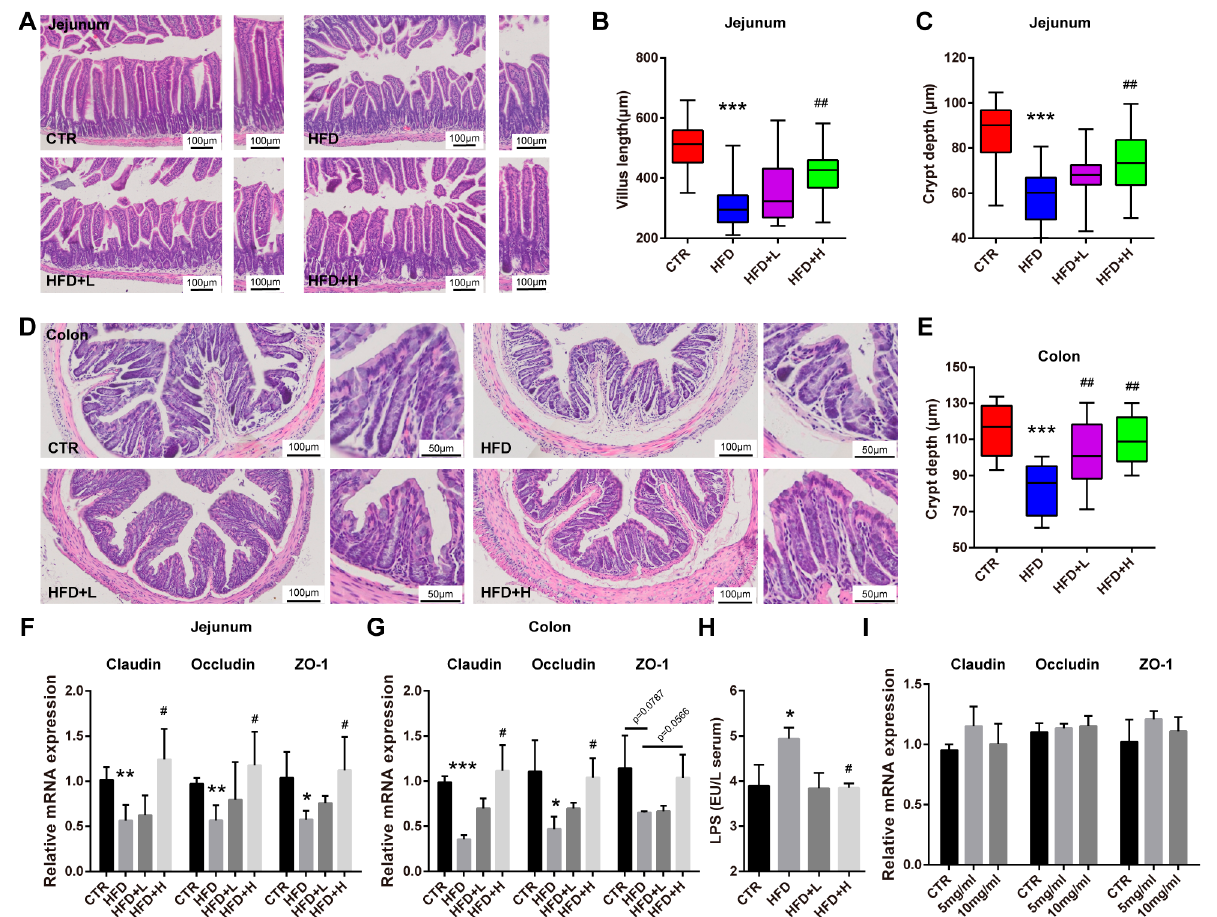
Figure 4. SMRR polysaccharide ameliorates defects in gut structure and permeability induced by high-fat diet. ( A – C ) Representative images of H&E staining and quantifications show SMRR polysaccharide reverses the defects in villus and crypt of jejunum induced by high-fat diet. Error bars indicate Mix to Max; n = 5; *** p < 0.001, ## p < 0.01 by one-way ANOVA; “*” stands for CTR vs. HFD, “#” stands for HFD vs. HFD+H. Different colors in ( B , C ) represent different groups. ( D , E ) Representative images of H&E staining and quantification show SMRR polysaccharide reverses the defects in crypt of colon induced by high-fat diet. Error bars indicate Mix to Max; n = 5; *** p < 0.001, ## p < 0.01 by one-way ANOVA. Different colors in ( E ) represent different groups. ( F , G ) qRT-PCR results show expressions of Claudin, Occludin and ZO-1 in jejunum and colon of mice from different groups. Error bars indicate SEM; * or # p < 0.05, ** or ## p < 0.01, *** p < 0.001 by one-way ANOVA; n = 4. ( H ) Quantification shows serum LPS levels in the mice from different groups. Error bars indicate SD; N = 3; * or # p < 0.05 by one-way ANOVA; ( I ) qRT-PCR shows no effects of SMRR polysaccharide on the expressions of Claudin, Occludin and ZO-1 in IPEC-J2 cells. Error bars indicate SEM; n =